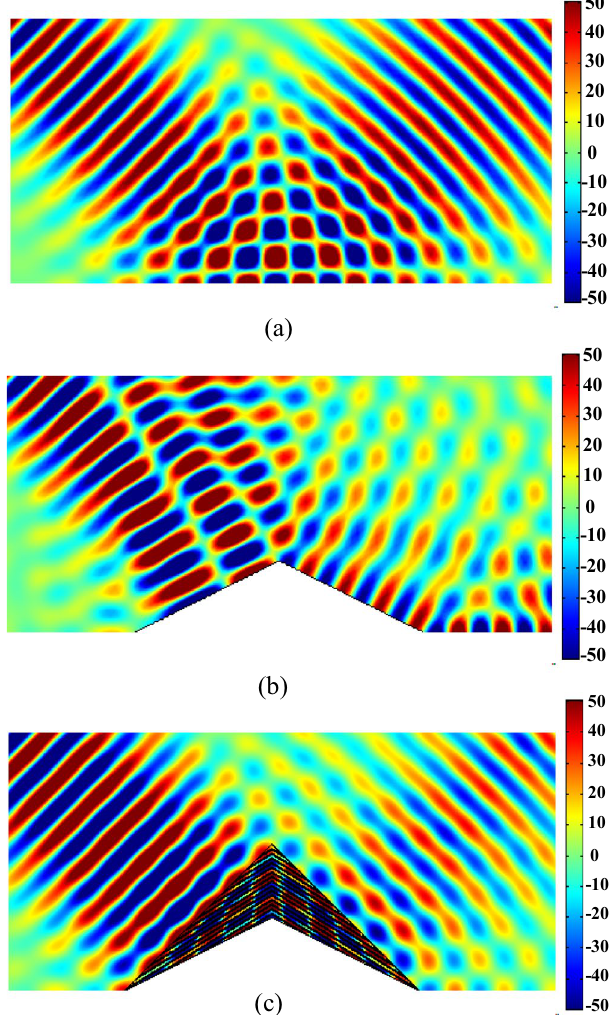
Figure 5. Numerically calculated magnetic field distributions of an incident light interacting with ( a ) a ground plane, ( b ) a bare conducting bump and ( c ) the bump covered by the proposed carpet